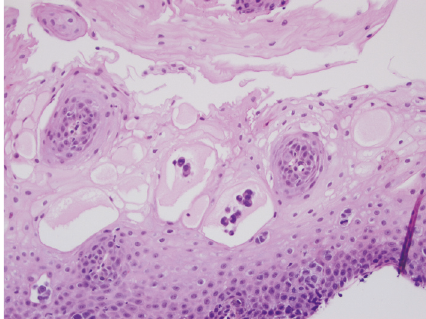
Figure 2: Pagetoid involvement of the squamous mucosa by the neoplastic cells (H&E, 20x).